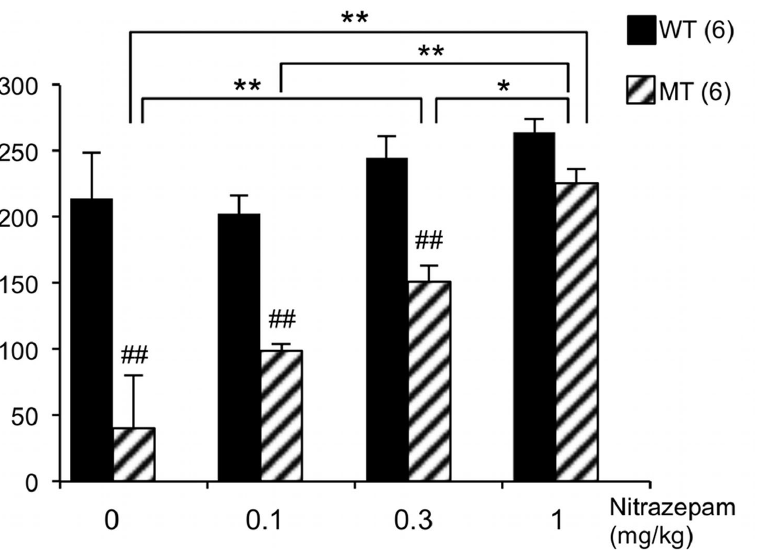
Figure 3. Effects of nitrazepam administration on tail suspension test (TST) immobility time. Nitrazepam induces dose-dependent increases of TST immobility time in Usp46 mutant mice (MT). Data are expressed as mean + S.E.M. for 6 mice in each group. ## P , 0.01 compared with the wild-type mice for each dose; * P , 0.05, ** P , 0.01 (two-way ANOVA with Bonferroni’s test).